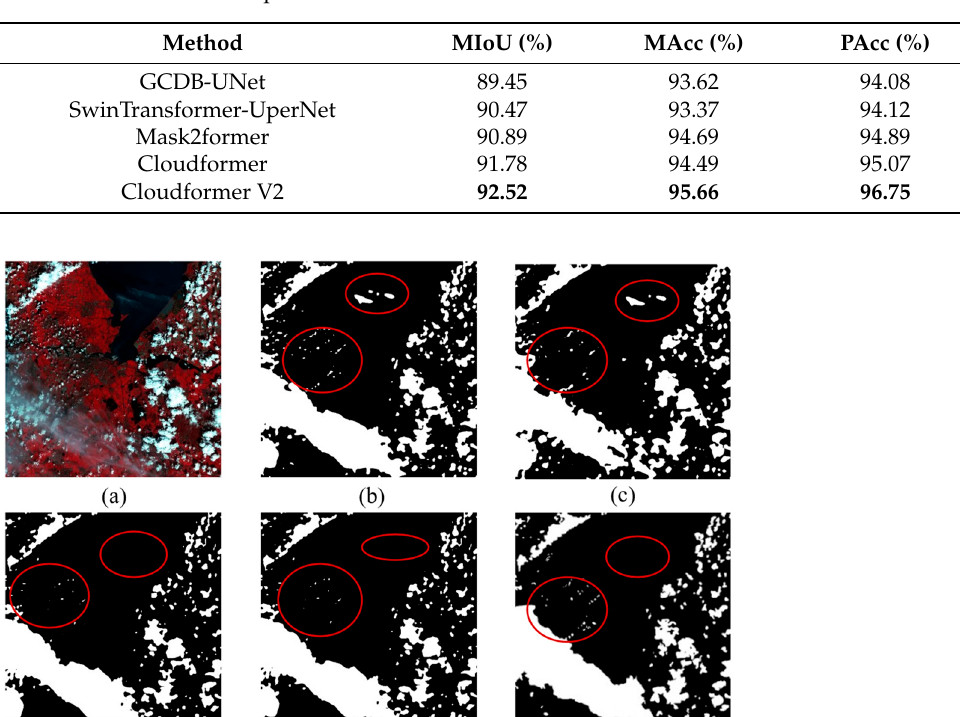
Figure 6. Comparison of visualization results. ( a ) BW loss ( b ) Base mask loss.